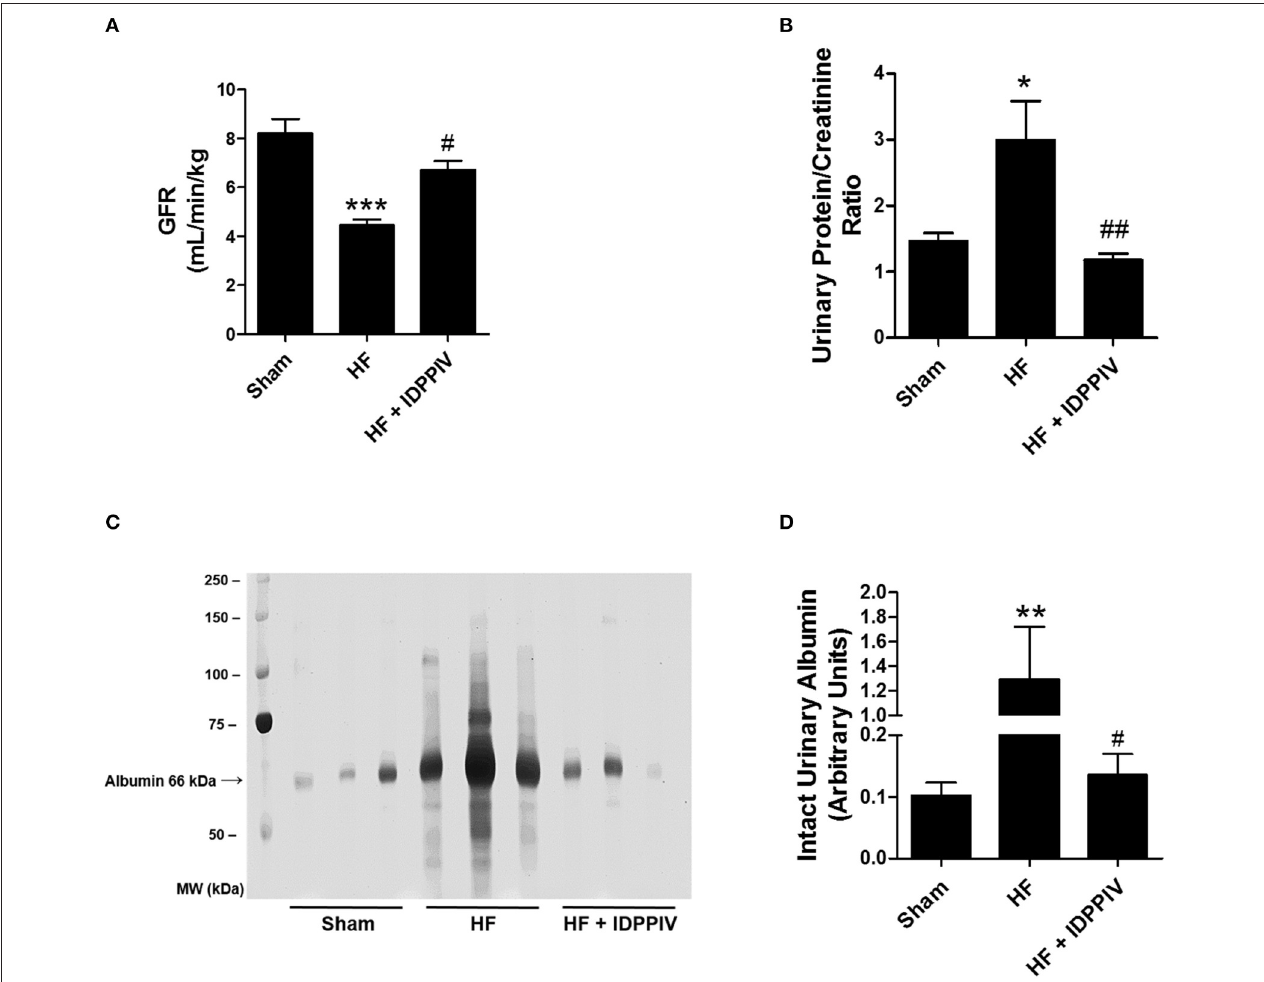
FIGURE 8 | DPPIV inhibition improves GFR and reduces proteinuria in HF rats. (A) The glomerular filtration rate (GFR) was estimated by the creatinine clearance. (B) Urine protein to creatinine ratio. n = 11–17 rats/group. (C) Profile of urinary proteins excreted by sham and HF rats treated with vehicle (HF) or vildagliptin (HF + IDPPV). The 24-h urine samples (volume equivalent to 25 µ g of creatinine) were subjected to 10% SDS-PAGE. Following electrophoresis, the gels were silver stained using the ProteoSilver Plus Kit (Sigma-Aldrich). (D) Graphic representation of the amount of intact albumin semiquantitatively evaluated by densitometry. n = 6 rats/group. Values are means ± SEM. * p < 0.05, ** p < 0.01 and *** p < 0.001 vs. Sham. # p < 0.05, ## p < 0.01 vs.